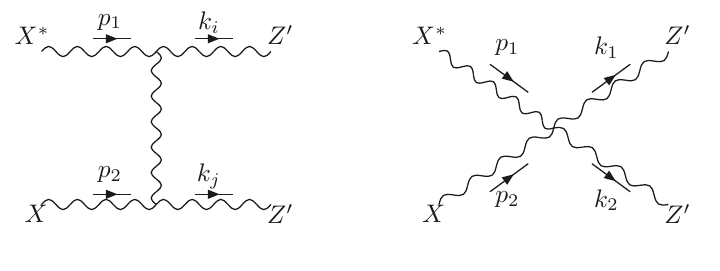
Figure 1 . Feynman diagrams of X ∗ + X → Z 0 + Z 0 processes. There are 2 independent diagrams with i, j = 1 , 2 and i 6 = j for the first